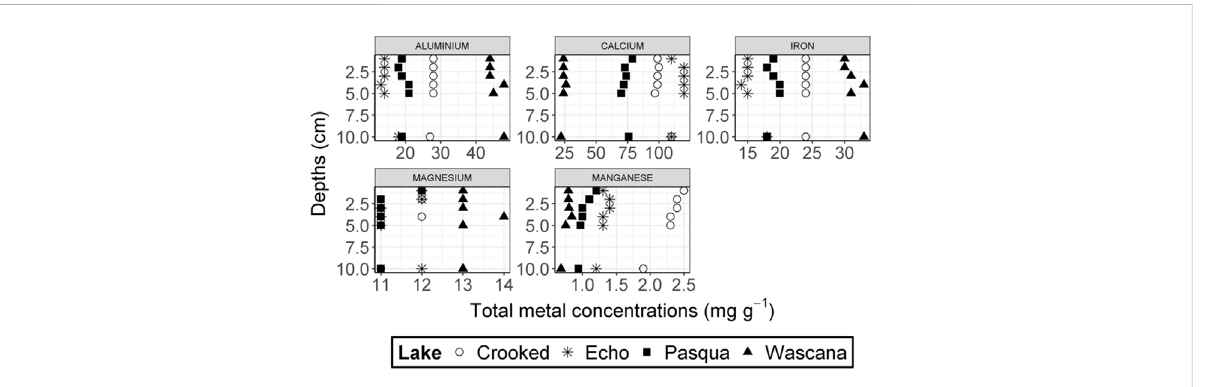
FIGURE 3 Concentrations of total sediment metal cations (mg g − 1 ) plotted against depth from the sampled Qu ’ Appelle lakes, Saskatchewan, Canada; n = 6sedimentsamplesperlake(noduplicateswereanalyzed).Eachpointcorrespondsto0 – 1-cm,1 – 2-cm,2 – 3-cm,3 – 4-cm,4 – 5-cm,and10 – 12-cm depth increments.